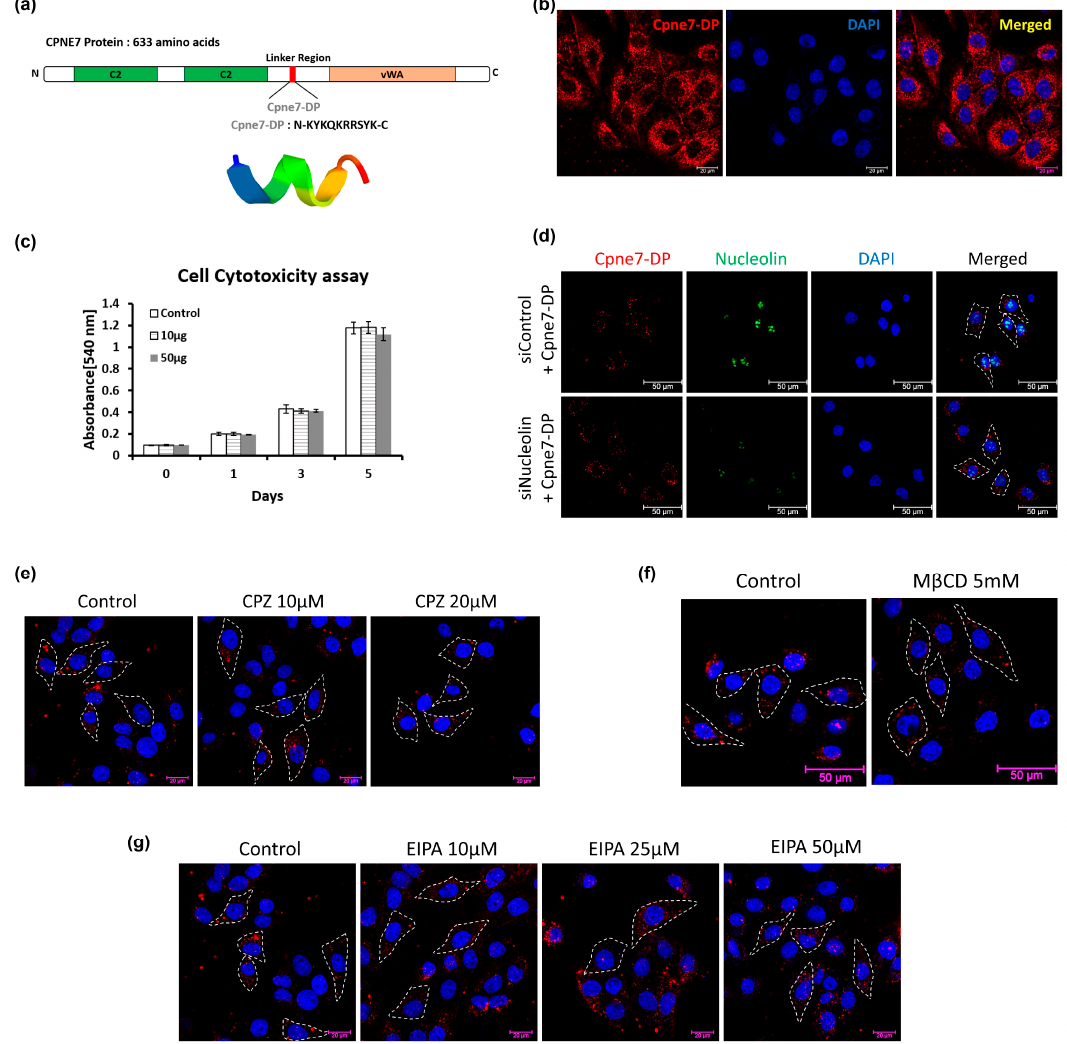
Figure 2. Functional peptide, Cpne7-DP directly penetrates odontoblastic cells. ( a ) Amino acid sequence and ribbon structure of Cpne7-DP derived from the linker region of CPNE7 protein. ( b ) Intracellular distribution of Cpne7-DP in odontoblastic MDPC-23 cells detected by immunofluorescence. ( c ) The e ff ect of Cpne7-DP on the proliferation of hDPCs was evaluated using an MTT (3-(4,5-dimethylthiazol-2-yl)-2,5-diphenyl tetrazolium bromide) assay. ( d ) Internalization of Cpne7-DP detected by immunofluorescence in MDPC-23 cells after treatment with nucleolin siRNA. MDPC-23 cells were pre-treated with nucleolin siRNA for 1 h before Cpne7-DP treatment. ( e ) Internalization of Cpne7-DP detected by immunofluorescence in MDPC-23 cells pre-treated with varying concentration of chlorpromazine (CPZ; 10 and 20 µ M) for 1 h before Cpne7-DP treatment. Dashed line indicates the cell edge. ( f ) Internalization of Cpne7-DP detected by immunofluorescence in MDPC-23 cells pre-treated with methyl-beta-cyclodextrin (M β CD) for 1 h before Cpne7-DP treatment. Dashed line indicates the cell edge. ( g ) Internalization of Cpne7-DP detected by immunofluorescence in MDPC-23 cells pre-treated with ethylisopropyl amiloride (EIPA) for 1 h before Cpne7-DP treatment. Dashed line indicates the cell edge. All values represent the mean ± standard deviation of triplicate experiments. DAPI, 4 (cid:48) , 6-diamidino-2-phenylindole; GAPDH, glyceraldehyde 3-phosphate